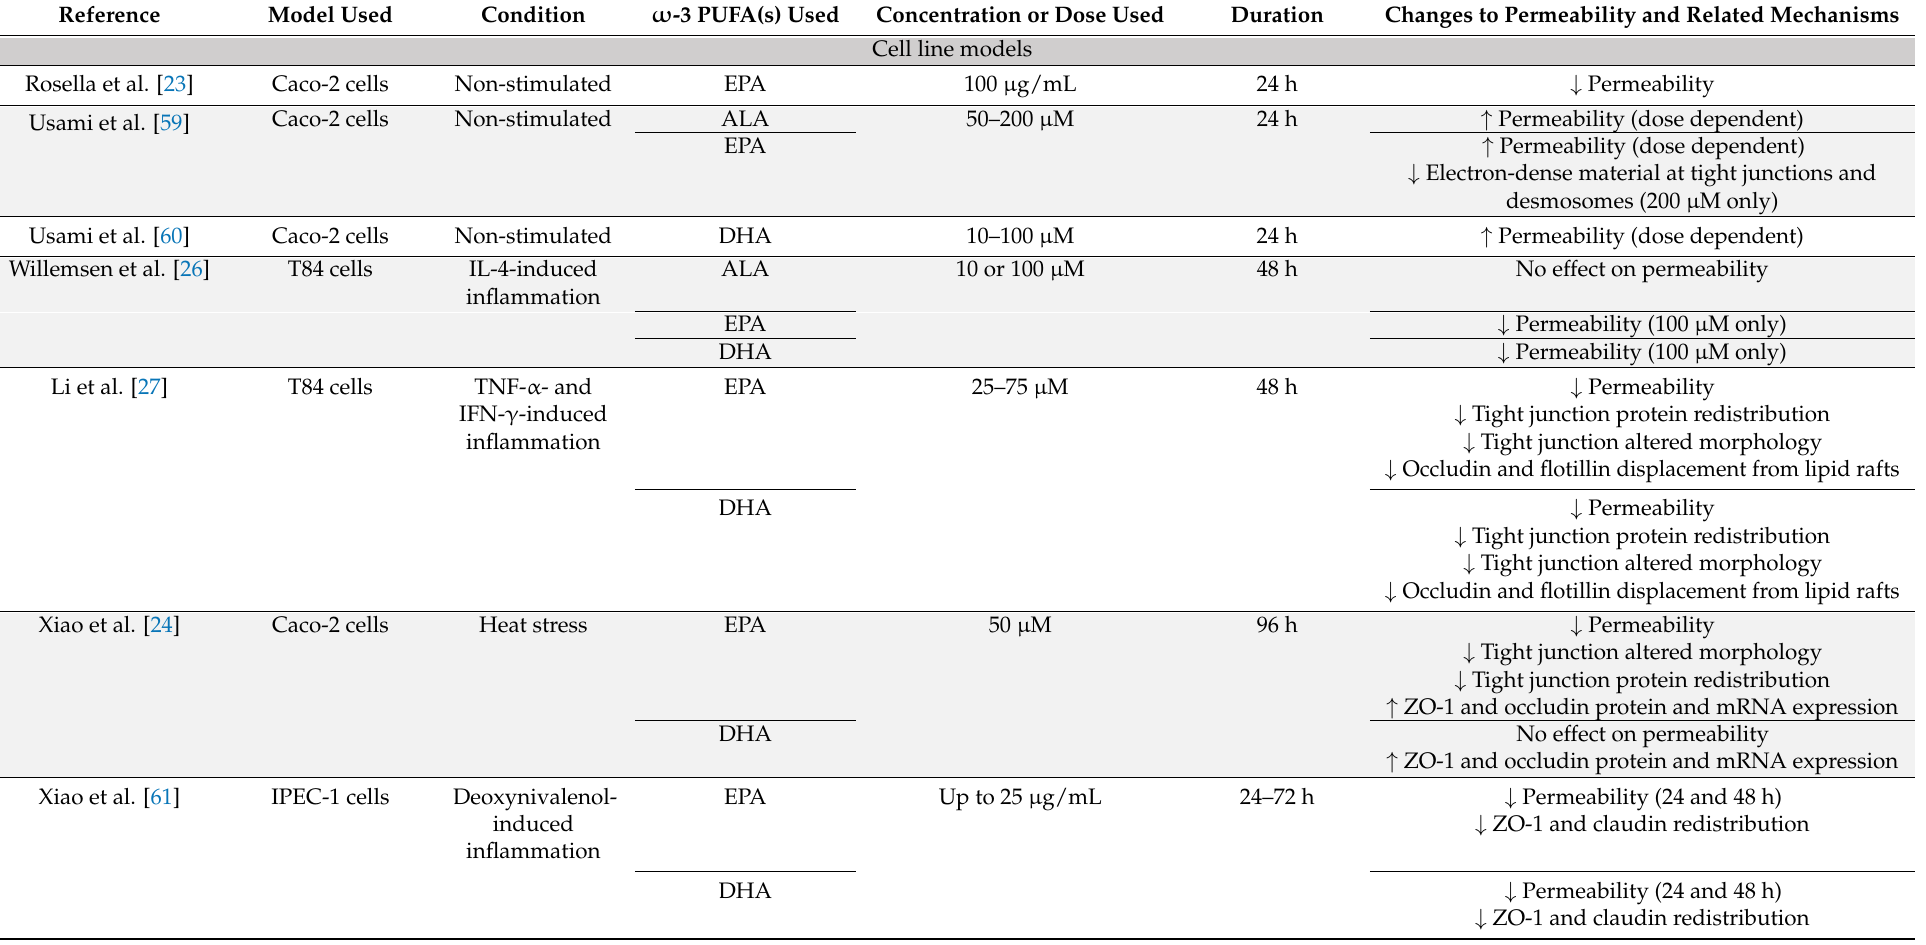
Table 4. Effects of ω -3 PUFAs on intestinal permeability in cell and rodent